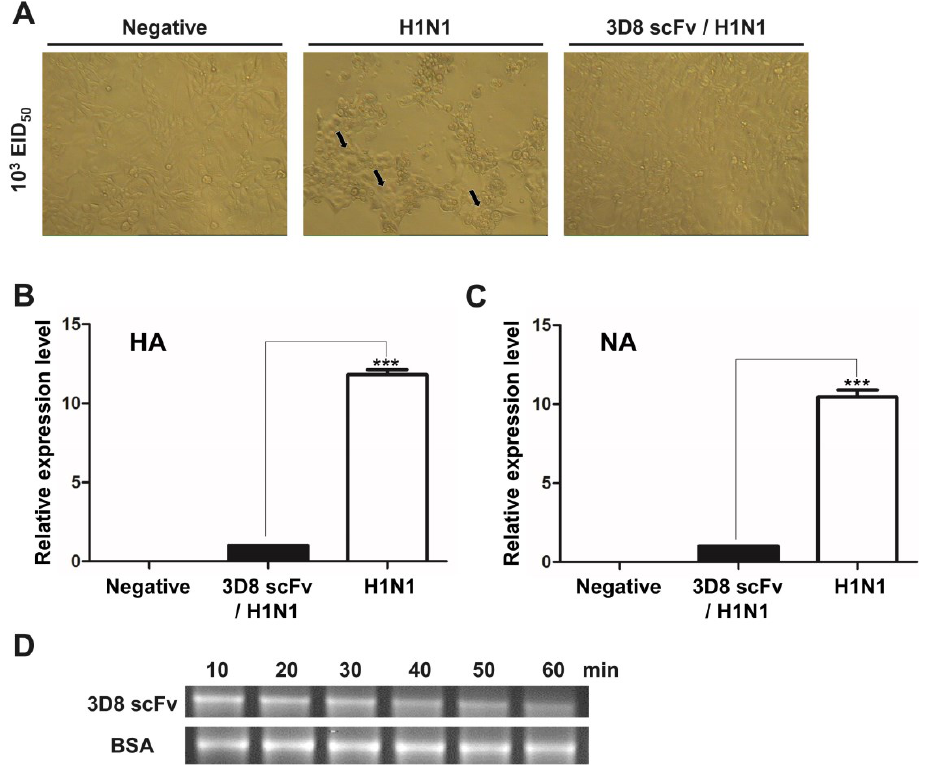
Figure 1. Direct catalytic activity of 3D8 scFv against H1N1 influenza virus. Madin-Darby Canine Kidney epithelical cells (MDCK cells) were infected with 200 μL of 10 3 EID 50 influenza virus for 4 h and then incubated for 24 h in serum-free medium with trypsin (1 μg/mL). ( A ) The cytopathic effects were examined by microscopy. Magnification 100 ˆ . The arrows indicated the cytopathic effects on host cells caused by H1N1 infection; ( B ) Transcripts of hemagglutinin and neuraminidase were measured by qRT-PCR and normalized by against GAPDH cDNA using the 2 ´ ∆∆ C t method. Data are shown as mean ˘ S.E.M of triplicate samples from three independent experiments. Data are mean ˘ standard error. *** Significantly different from 3D8 scFv/H1N1 group at p < 0.001 (one-way analysis of variance and Tukey’s post hoc t -test); ( C ) The RNA transcript of hemagglutinin was incubated with 3D8 scFv purified protein for 1 h; ( D ) Reactions were terminated at 10, 20, 30, 40, 50 and 60 min and analyzed by